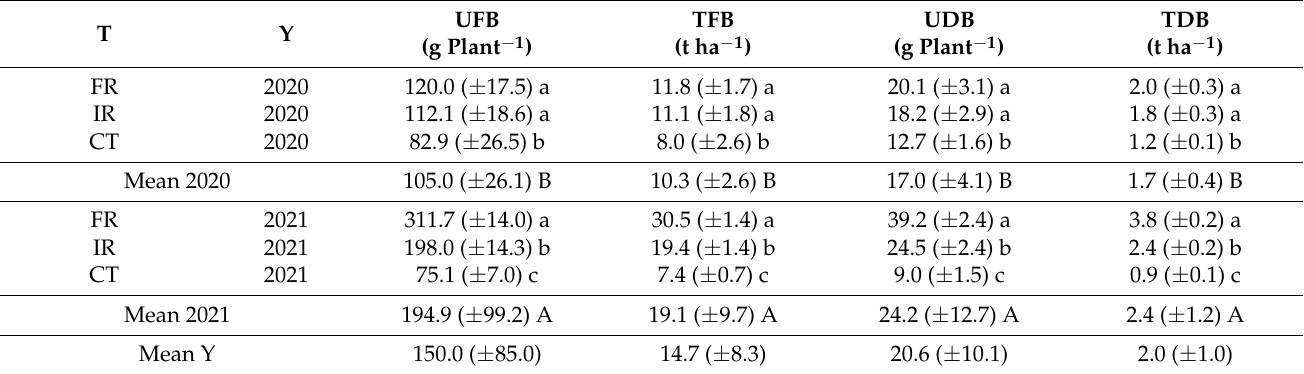
Table 6. Estimated biometric marginal mean differences calculated with the Bonferroni adjustment between the density treatments relative to weights of flower heads and tubules. Means ( ± standard deviation) within each column followed by different lowercase and uppercase letters are significantly different (ANOVA, p < 0.05) among the treatments in the same year and between the two years (by averaging each of the values of the three treatments),